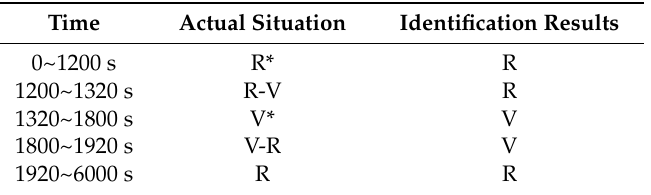
Figure 7. Coe ffi cient of variation (COV) COV of every 30 cycles with interval of 100 cycles. Figure 7. Coefficient of variation (COV) COV of every 30 cycles with interval of 100 cycles. Table 2. Comparison of identification results with actual